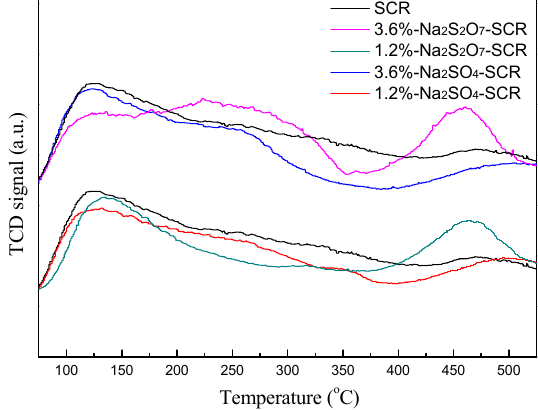
Figure 5. NH 3 -TPD profiles of the catalyst samples.